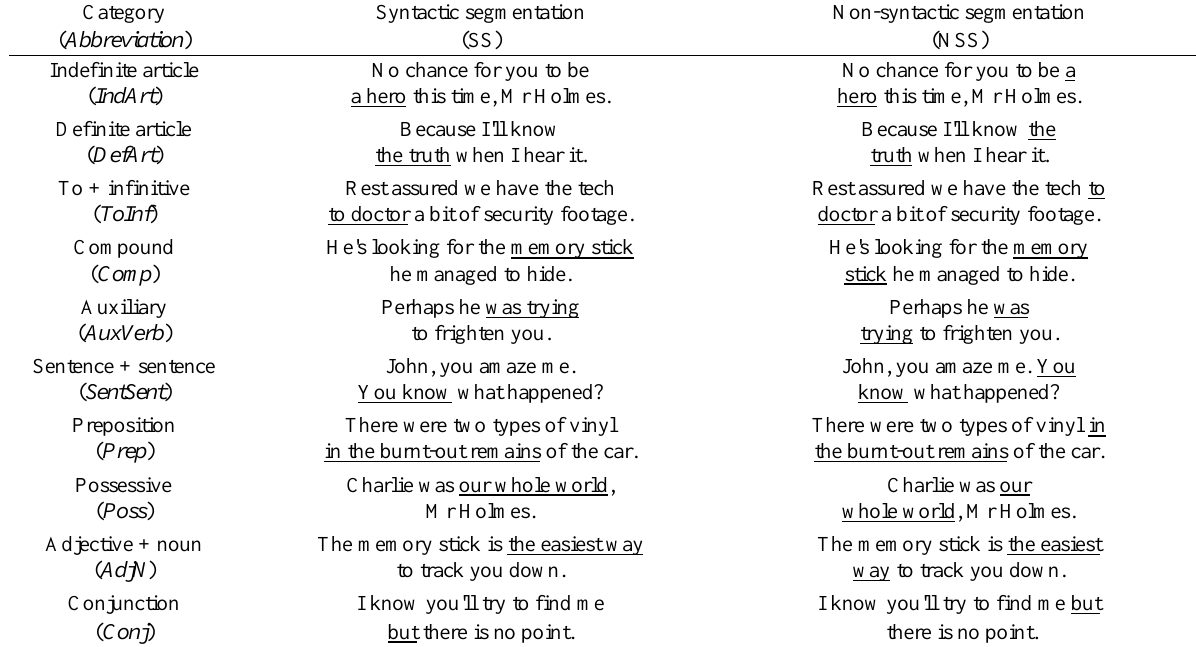
Table 1. Examples of linguistic units manipulated in the syntactically segmented and non-syntactically segmented versions.